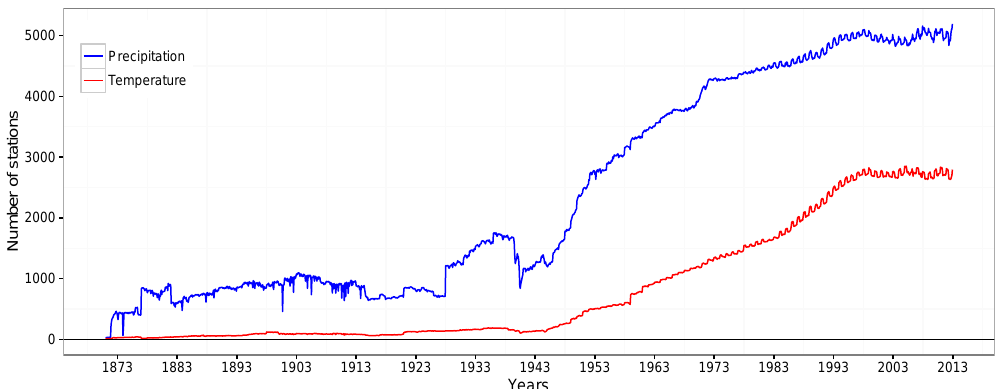
Figure 1. Evolution of the monthly averaged number of available precipitation and temperature stations in the Météo-France database (as of March 2015) since